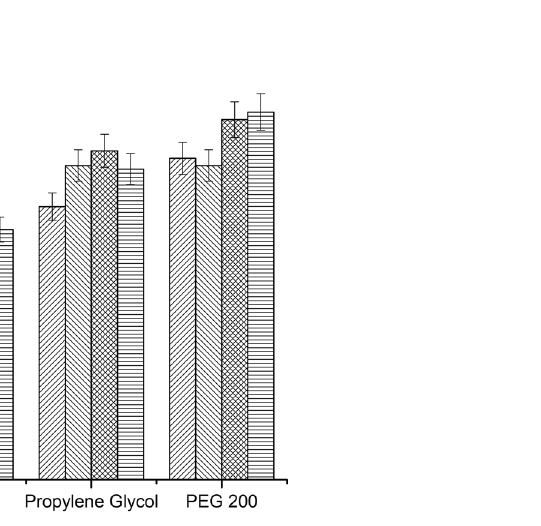
Figure 3. Lineweaver–Burk plot for enzyme–substrate reaction (1/V vs 1/S) ( a ) Control (water), ( b ) Heptane, ( c ) Propylene glycol and ( d ) PEG 200. Reaction was conducted by varying the concentration of starch in the range of 10–100 mg/ml along with 1 ml of enzyme (having activity of 4.6 mmol/min/ml in water, 6.5 mmol/ min/ml in heptane, 5.3 mmol/min/ml in propylene glycol and 6 mmol/min/ml in PEG 200) and 1 ml of the respective solvent incubating at 30 ℃ and at a pH of 6.9 for 10 min.